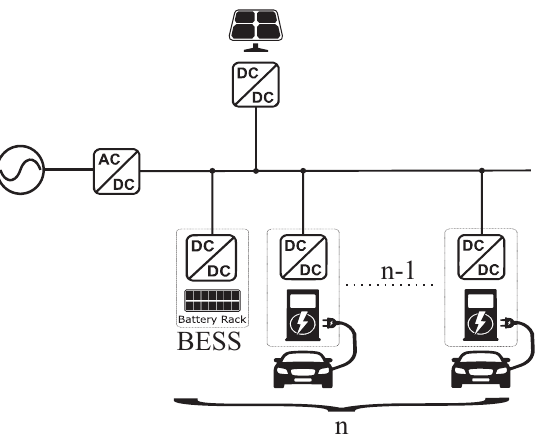
Figure 1. High-level view of the charging station structure composed of n storages with different priority.